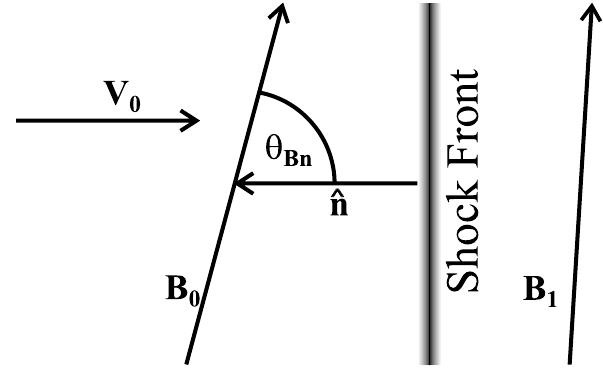
Fig. 1. The geometry of a collisionless shock in the normal inci- dence frame. The magnetic field B , inflow velocity V 0 and shock normal ˆ n are co-planar. In this reference frame, the geometry is such that V 0 and ˆ n are